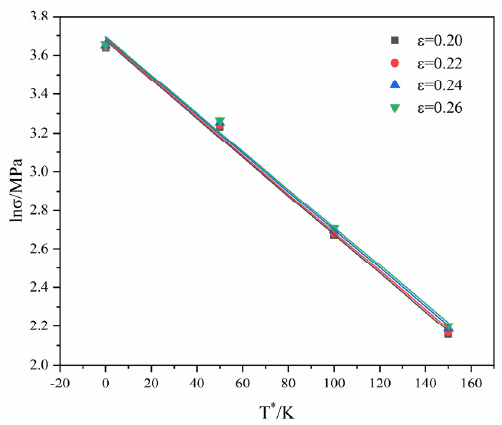
Figure 7. Linear fitting of ln σ against T ∗ .